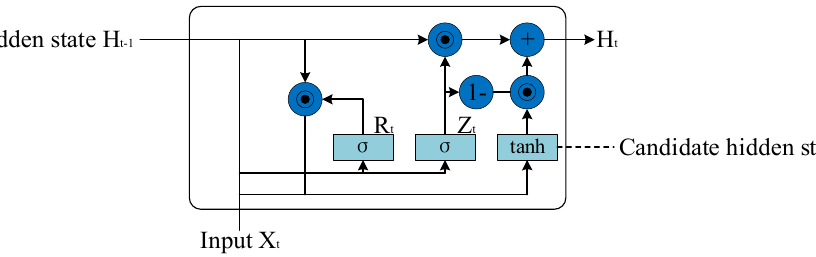
Figure 4. Comparison of MLM task structures with different strategies.